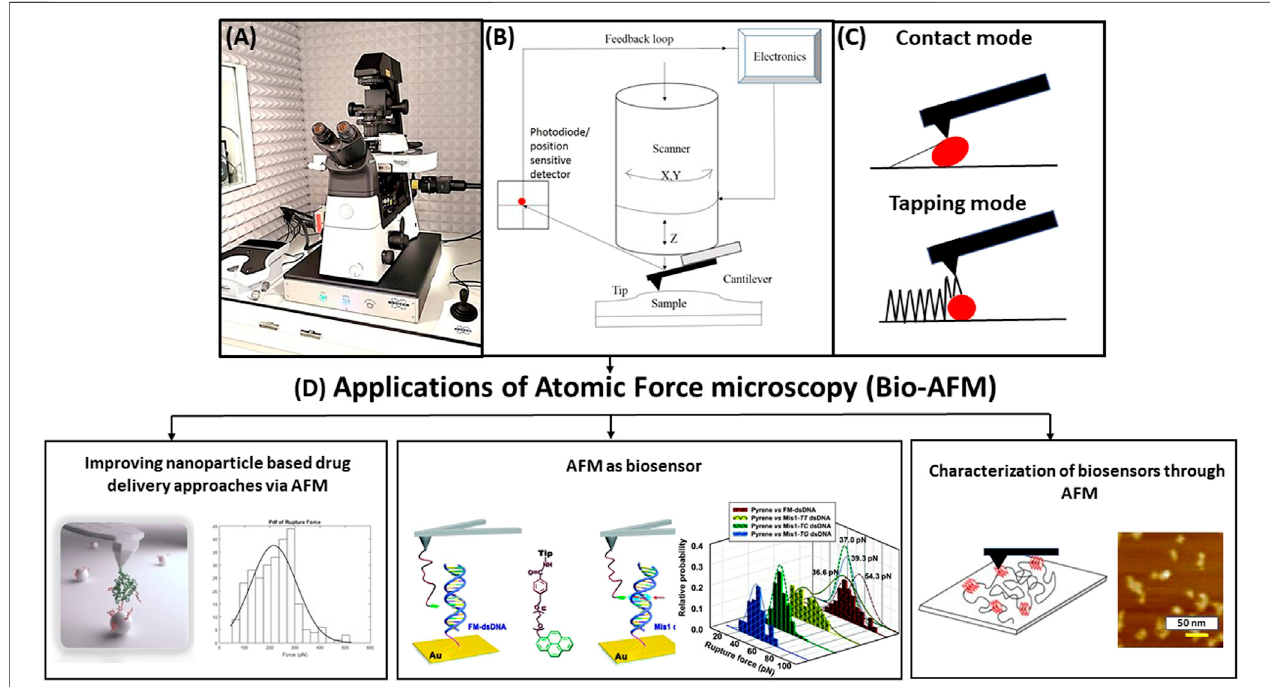
FIGURE1|(A) Schematicdiagramofbio – atomicforcemicroscopy(AFM)setupsittinginsideavibrationisolationhood. (B) BasicworkingprincipleofAFMshowing the major components like fl exible cantilever with a sharp tip at the end, piezoelectric scanner, and cantilever de fl ection detection system, i.e., split photodiode and position sensitive detector, AFM electronics, feedback loop, cantilever, and sample holder. (C) Two basic modes of operation: contact mode (continuous contact of tip andsample)andtappingmode(intermittenttappingbythetiponsample). (D) Applicationsofbio-AFMto(1)improvenanoparticle-baseddrugdeliveryapproaches (i.e., measuring the size, shape, and morphology of the drug delivery carriers and fi nding a suitable carrier by measuring the most probable unbinding force and binding probability (Jones et al., 2017); (2) serve as a biosensor (for example, biosensing of DNA via AFM by measuring most probable unbinding forces between matched and mismatched pairs of dsDNA) (Wei et al., 2013); and (3) characterize the morphology, roughness, and nanomechanical properties of the biosensors (for example, characterization of G-quadruplex electrochemical biosensor was performed using AFM as shown here) (Chiorcea-Paquim et al., 2015).